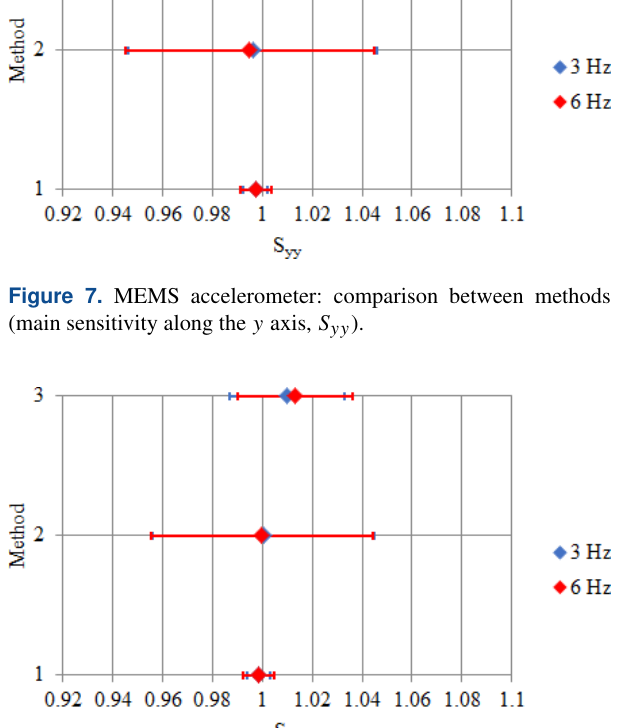
Figure 6. MEMS accelerometer: comparison between methods (main sensitivity along the x axis, S xx ).